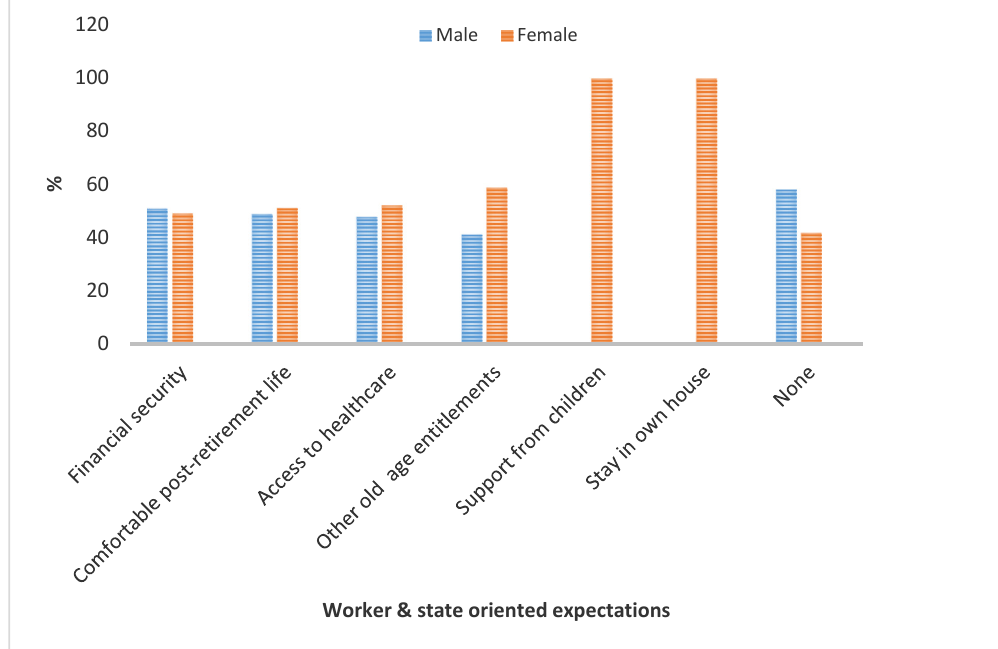
Figure 1. Retirement expectations. Source: Field data.